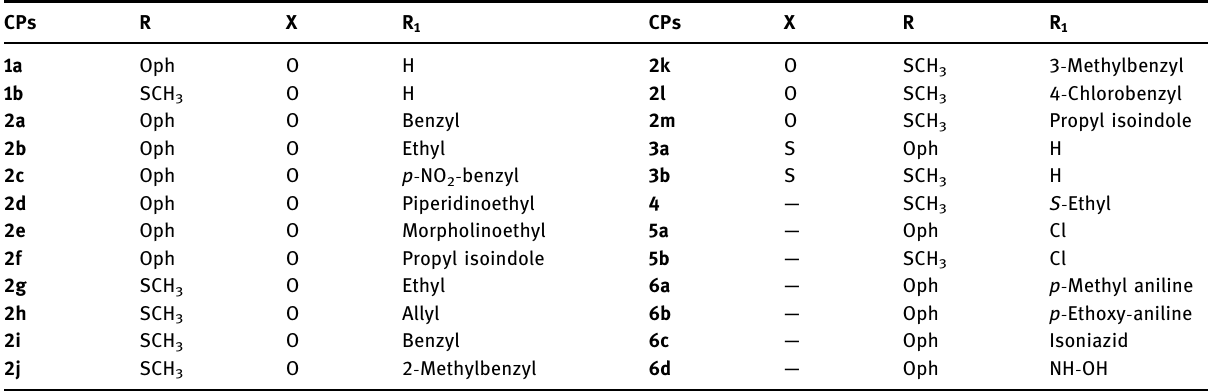
Table 1: The synthesized pyridotriazolopyrimidines ( 1 – 6 )